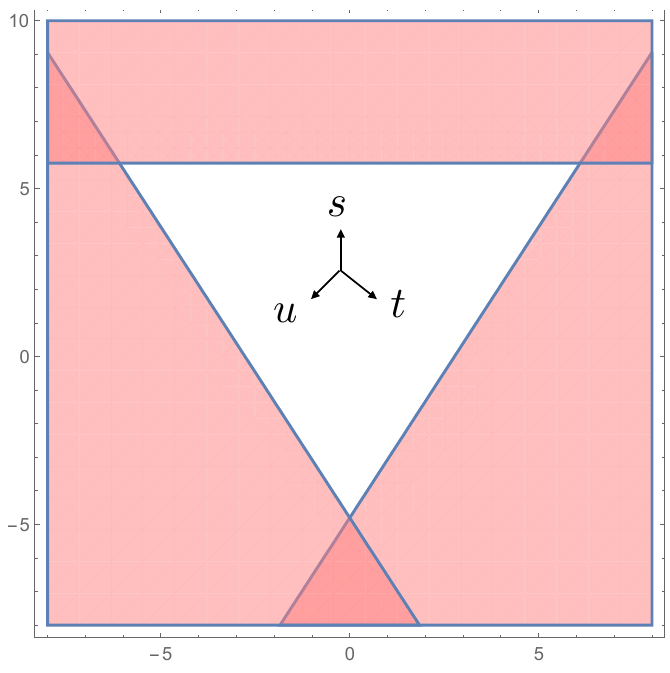
Figure 14. The Mandelstam triangle is the region where all Mandelstam variables are below their corresponding two-particle threshold: s < max(( m a + m b ) 2 ; ( m c + m d ) 2 ) m c ) 2 ; ( m b + m d ) 2 ) u < max(( m a + m d ) 2 ; ( m b + m c ) 2 ) represented by the white region in this ^ (cid:12)gure. (The y axis is s and the x axis is given by x = ( s + 2 t next